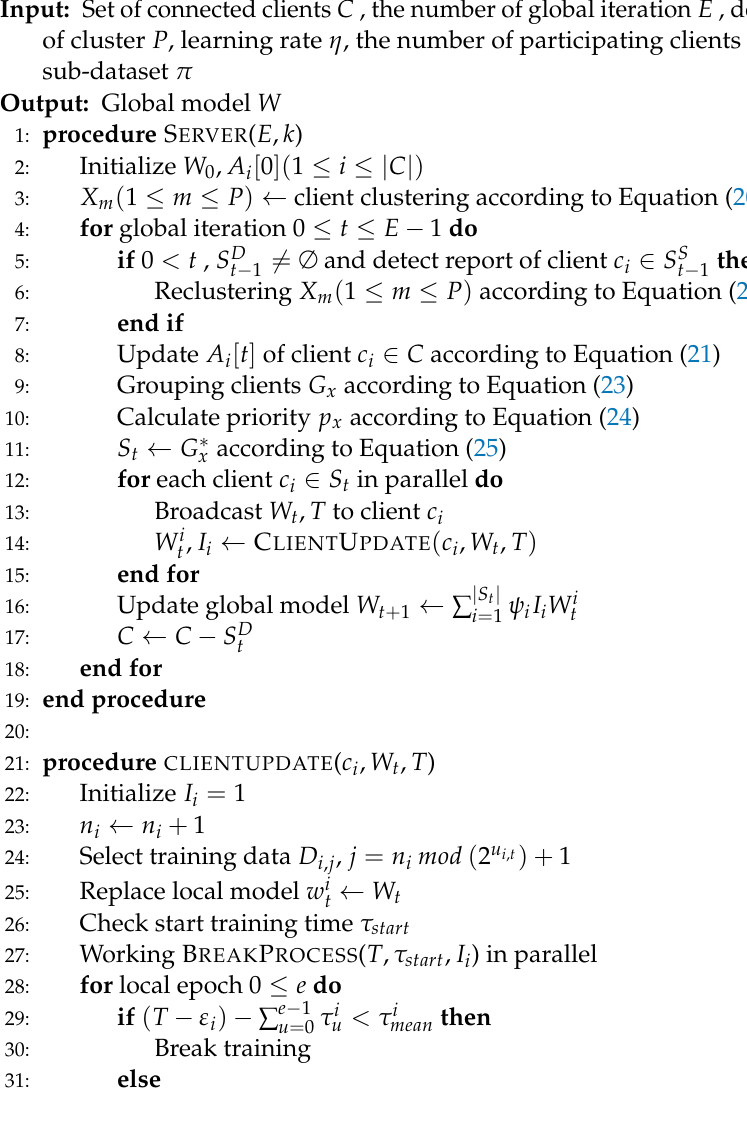
Algorithm 2 Algorithm of